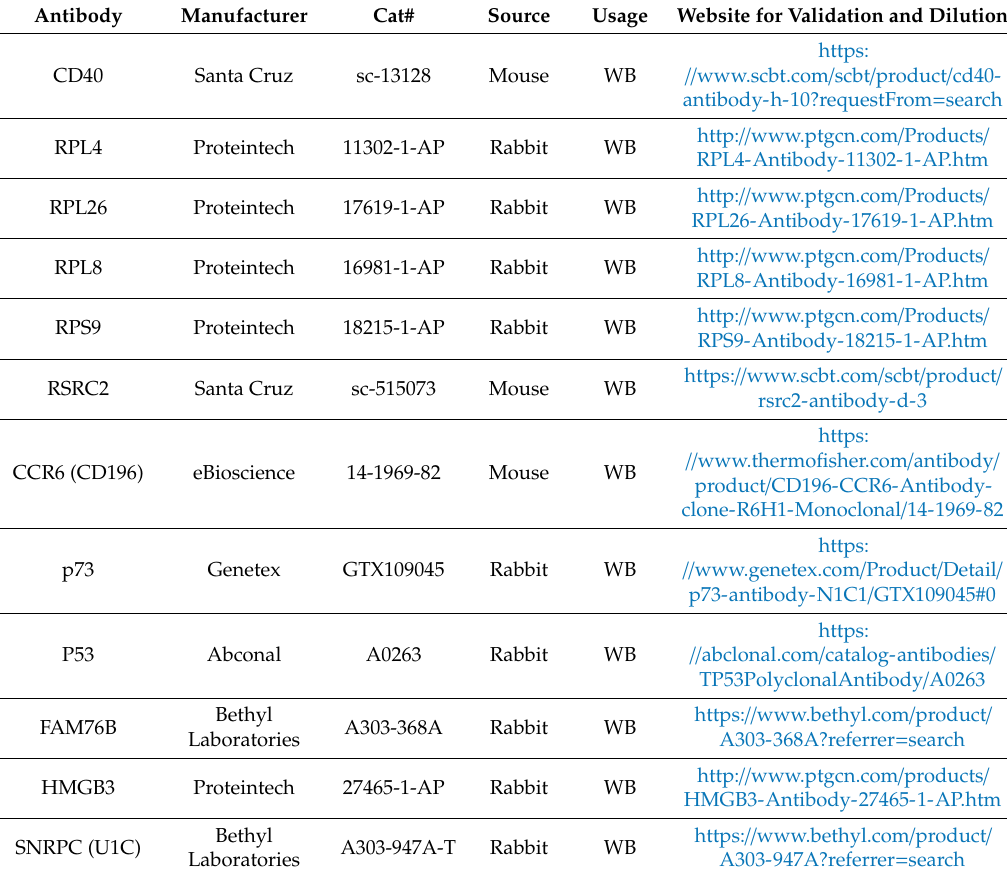
Table A2. Antibodies used in this